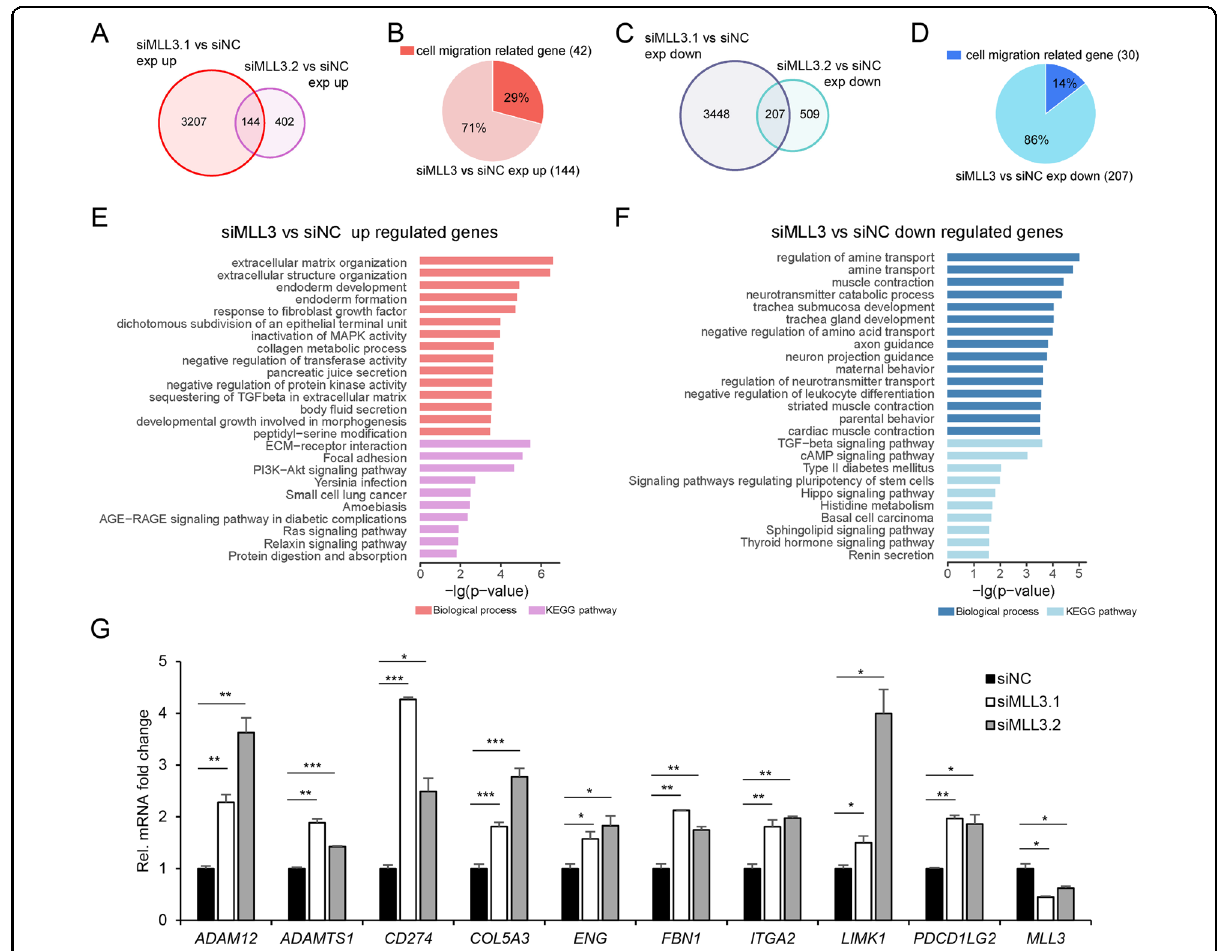
Fig. 2 Gene expression pro fi les regulated by MLL3. A MLL3 was knocked down with two different siRNAs in U2OS cells. DEGs (fold change > 1.5) between control and each siRNA were identi fi ed. Venn Diagrams show the number of upregulated genes between control and two MLL3 siRNAs. B The percentage of cell migration-related genes in the overlapped upregulated genes. C Venn Diagrams show the number of downregulated DEGs (fold change > 1.5) between control and two MLL3 siRNAs. D The percentage of cell migration-related genes in downregulated genes. E , F Biological process and KEGG pathway enrichment analyses of upregulated DEGs ( E ) or downregulated DEGs ( F ) were performed with DAVID, and items were ordered by p value. G Veri fi cation of chosen upregulated cell-migration-related DEGs after MLL3 knockdown by qRT-PCR. Histograms show the relative mRNA fold change presented as mean ± SD ( n = 3). * P < 0.05, ** P < 0.01, *** P <